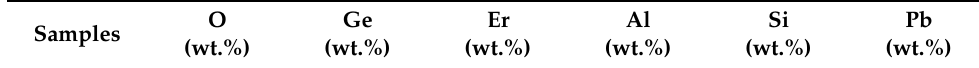
Table 4. The content of different elements in the fiber samples.